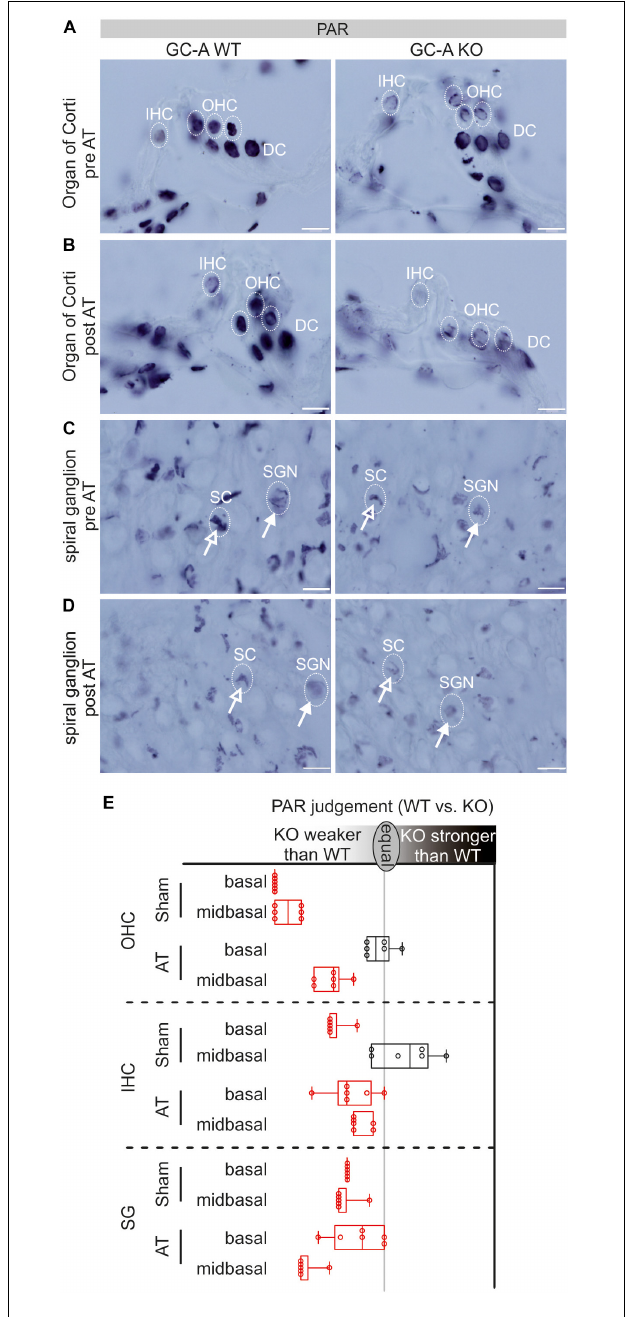
FIGURE 7 | PAR-staining in organ of Corti and SG in GC-A WT and KO mice pre and post acoustic trauma. (A) Reduced PAR-staining of OHC nuclei but not DCs in the GC-A KO mouse. No difference was found for IHC in mid-basal turns. (B) After acoustic trauma, a reduction of PAR (not significant) was shown for IHC and OHCs in the GC-A KO mice, compared to WT. (C) PAR-staining in SG of SGNs (closed arrow) and satellite cells (SCs, open arrow) in sham-exposed GC-A WT and KO mice. (D) After acoustic trauma, GC-A KO animals had weaker PAR-staining of SCs and SGNs than WT mice. Scale bars: 10 µ m. (E) Quantification of PAR-staining in OHC, IHC, and SG as evaluated by six independent referees; red colors indicate a reduction of